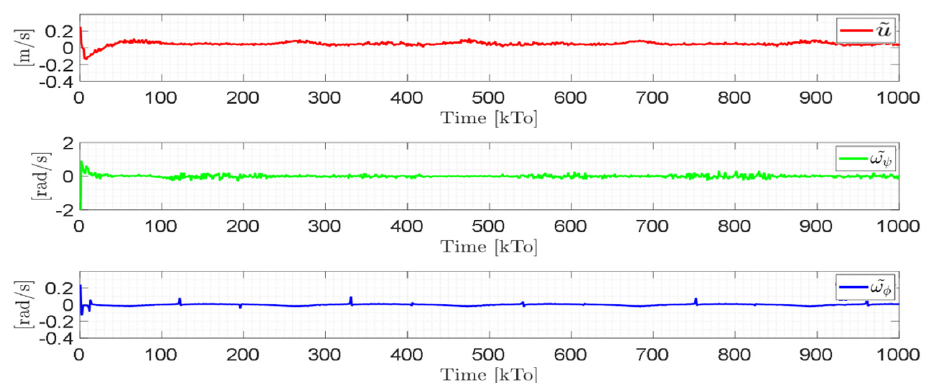
Figure 24. Time evolution of the velocity errors (cid:101) µ ( t ) = Velocity errors are caused by wheel slippage and by frictional forces between the wheelchair and the surface where the tests are being run (virtual environment). Therefore, the velocity errors are limited. In this experiment, the bound of the maximum velocity error is max (cid:107) (cid:101) µ ( t ) (cid:107) < 0.1. Figure 25 shows the control actions applied to the standing wheelchair robot during the experimental test.